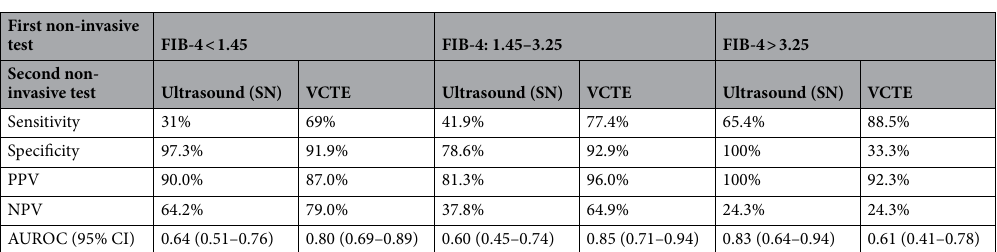
Table 6. Performance of stepwise algorithms of FIB-4 followed by ultrasound surface nodularity or VCTE for prediction of advanced fibrosis. AUROC, area under receiver operating characteristic curve; CI, confidence interval; kPa, kilo pascal; LSM, liver stiffness measurement; NPV, negative predictive value; PPV, positive predictive value; SN, surface nodularity; VCTE, vibration controlled transient elastography.